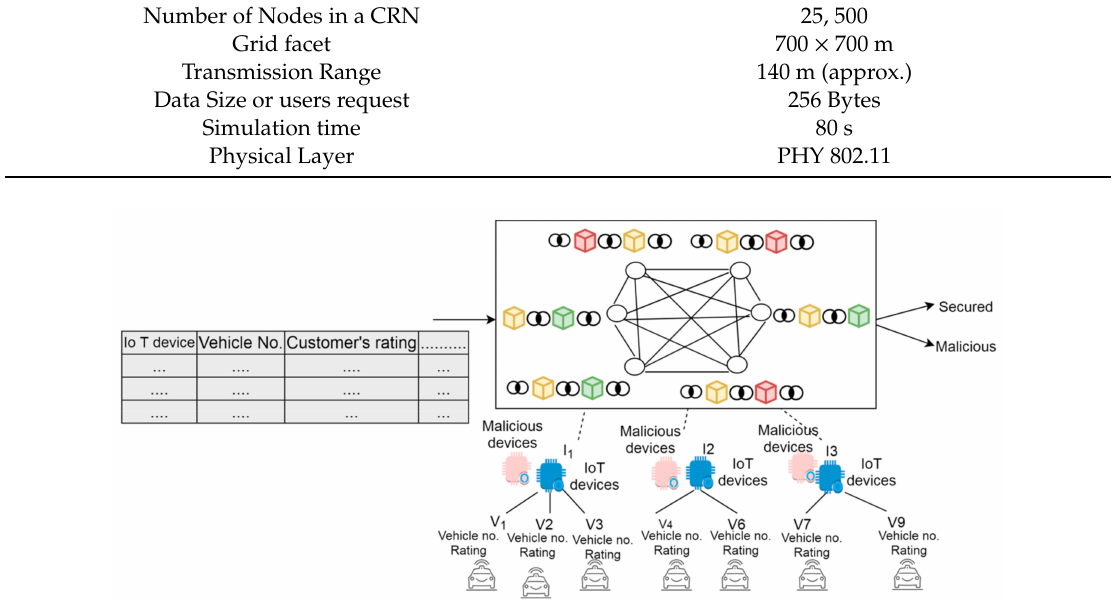
Figure 7. An adversary network model of the proposed